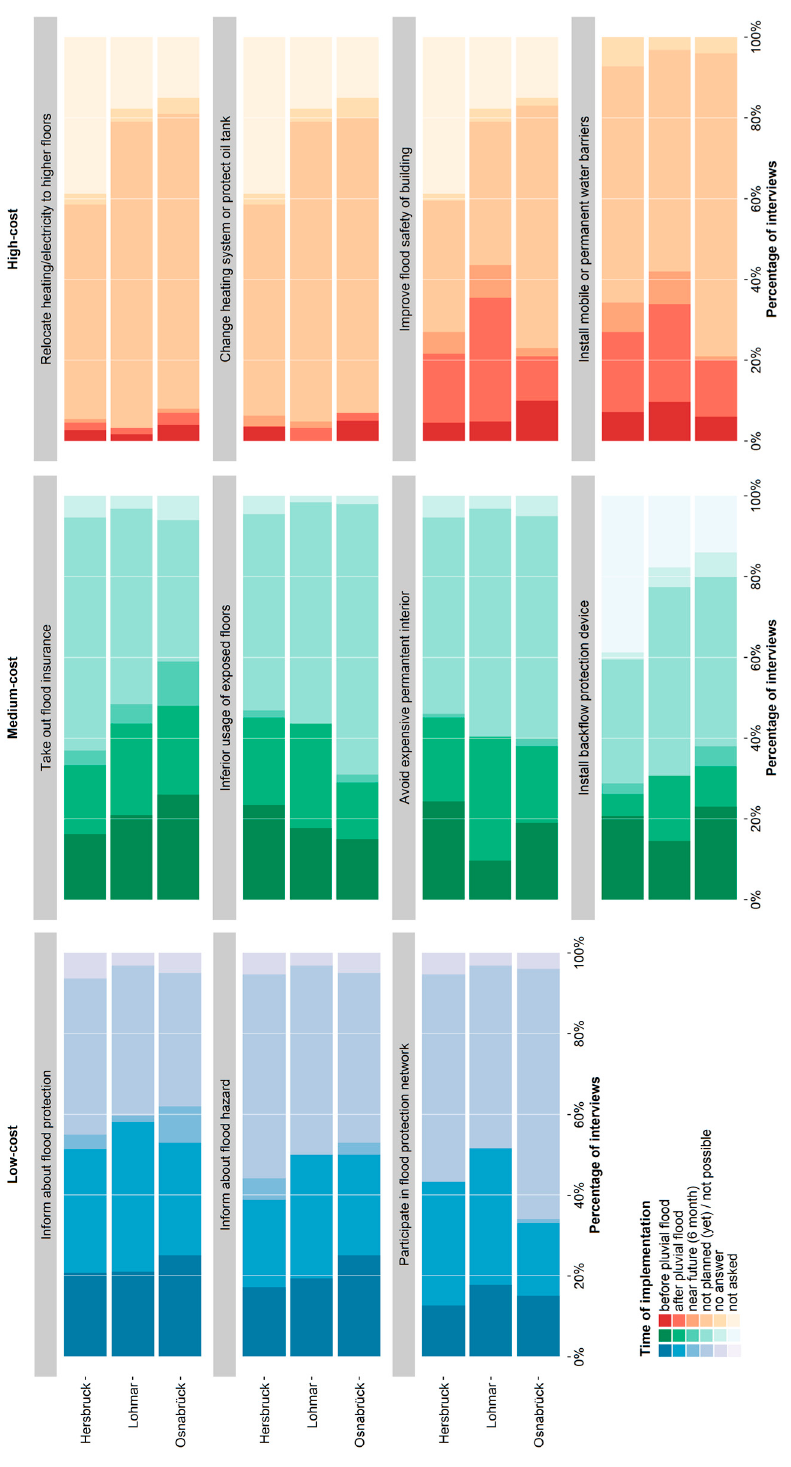
Figure 2. Private precautionary measures undertaken by event, time of implementation and